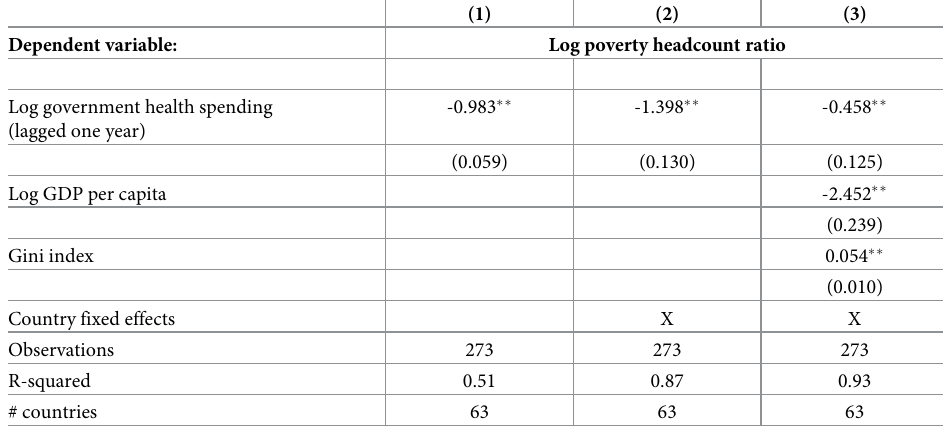
Standard errors in parentheses. Statistical significance